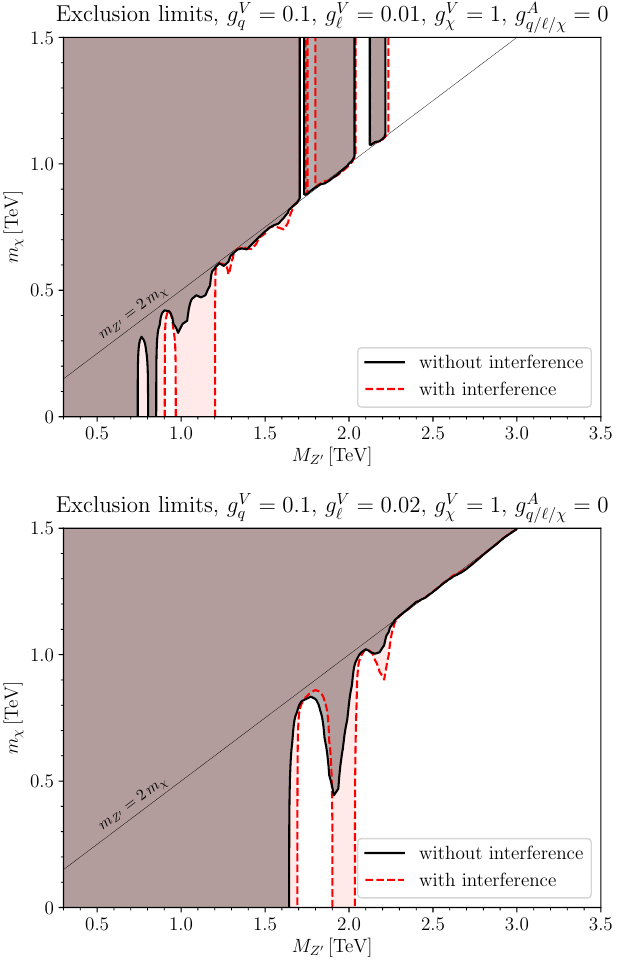
Figure 5 . Excluded parameter space at 95 % con(cid:12)dence level in the m Z and without interference e(cid:11)ects for a simpli(cid:12)ed DM model with vanishing axial couplings. Both panels assume g V = 1 : 0 and g V = 0 : 1, while the lepton coupling is set to g V (cid:31) q panel and g V = 0 : 02 in the bottom ‘